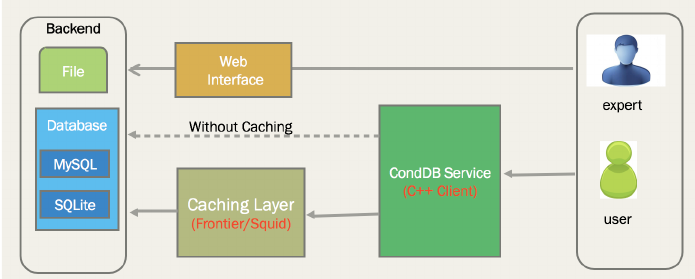
Fig. 1. Overview of JUNO Conditions Data Management